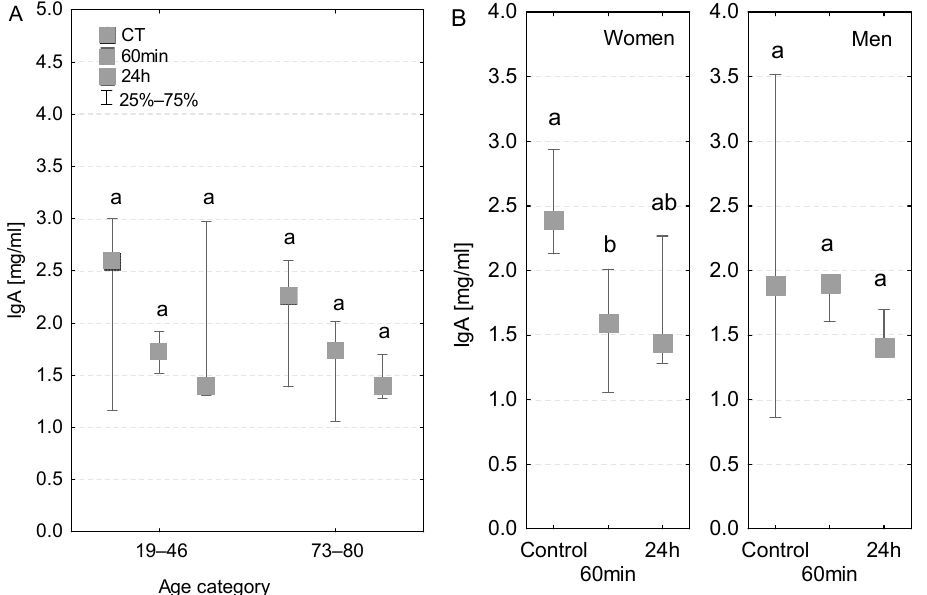
Figure 6. Serum IgA concentration (median ± quartile deviation; 25th and 75th percentiles). ( A ) Comparison based on the age of patients: 19–46 years and 73–80 years. ( B ) Comparison based on the sex of the patients. CT: measurement before the onset of CPB; 60 min: measurement at 60 min of the CPB onset; 24 h: measurement at 24 h after the onset of CPB. Values with different letters (a, b) indicate significant differences within the age or sex category (Friedman’s test or Mann–Whitney U test; p < 0.05).